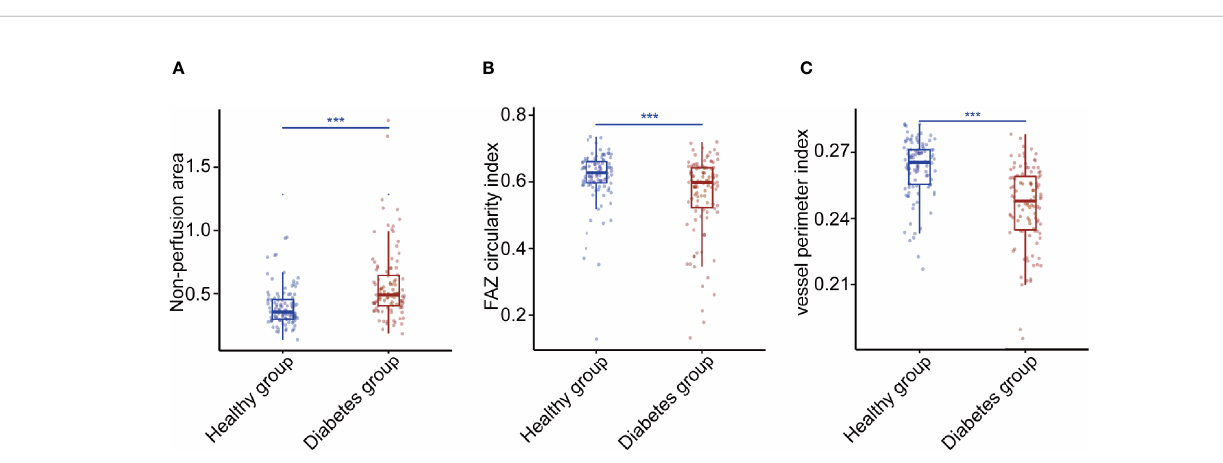
FIGURE 5 | Three OCTA metrics closely related to diabetes. (A) The Wilcox result of non-perfusion area. (B) The Wilcox result of foveal avascular zone circularity index. (C) The Wilcox result of vessel perimeter index. P-values were corrected by FDR. *p < 0.05, **p < 0.01, and ***p < 0.001. FAZ, foveal avascular zone.